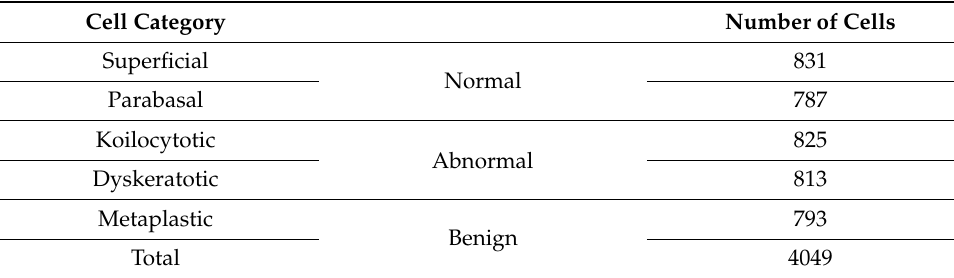
Figure 5. Sample images from Sipakmed dataset. Table 4. Sipakmed